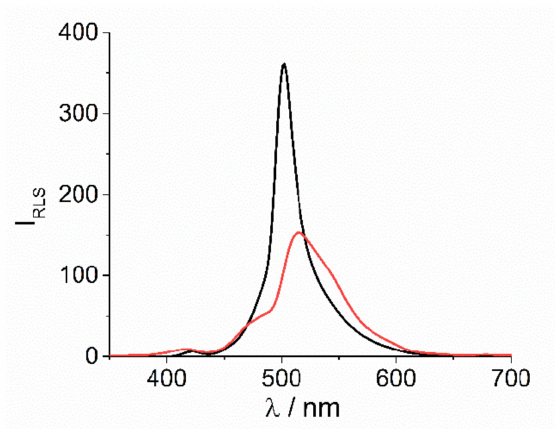
Figure 2. RLS profiles for the final J-aggregates of H 2 TPPS 4 at pH = 2 upon the addition of [Co(phen) 3 ] 3+ (black solid line) and [Co(NH 3 ) 6 ] 3+ (red solid line) (Experimental conditions: [H 2 TPPS 4 ] = 3 µ M; [HCl] = 0.01 M, [CoL n3+ ] = 200 µ M, T = 298